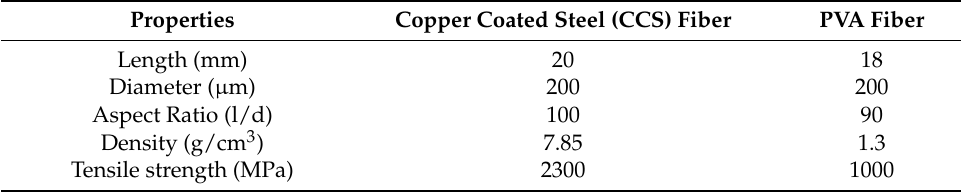
Table 1. Physical and Mechanical Properties of fibers